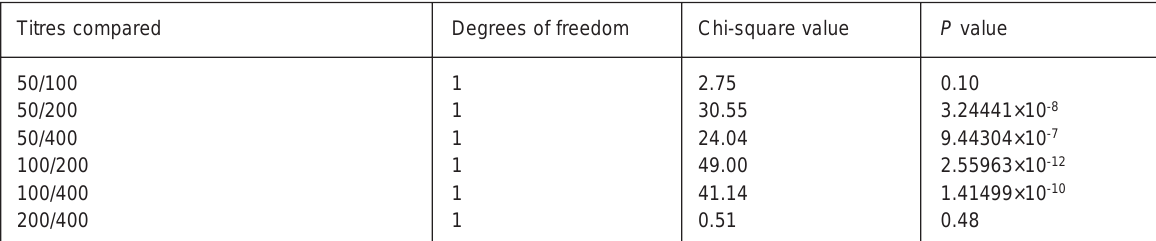
TABLE 4 Comparison of seropositive small ruminants at each individual antibody titre using the Chi-square test Titres